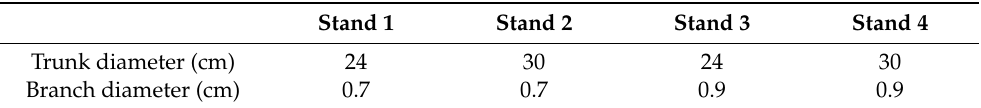
Table 4. Diameters of Aspen